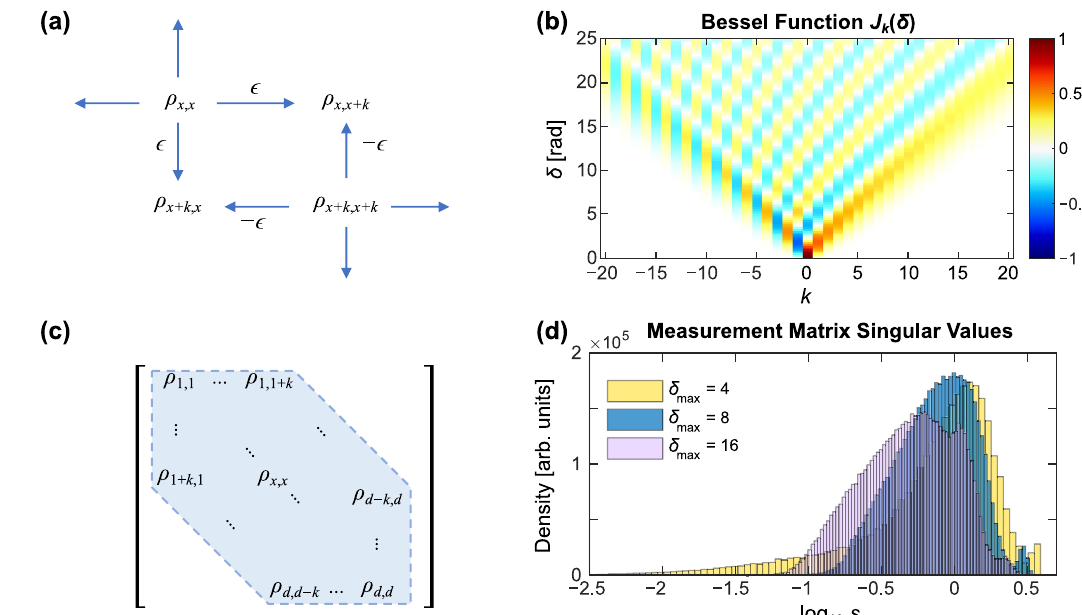
below the diagonal. d Distribution of singular values for random measurement matrices O for d =8, δ 2 ½ 0 δ max (cid:3) , and R =2 d : δ max =4 (gold); δ max =8 (blue); δ max =16